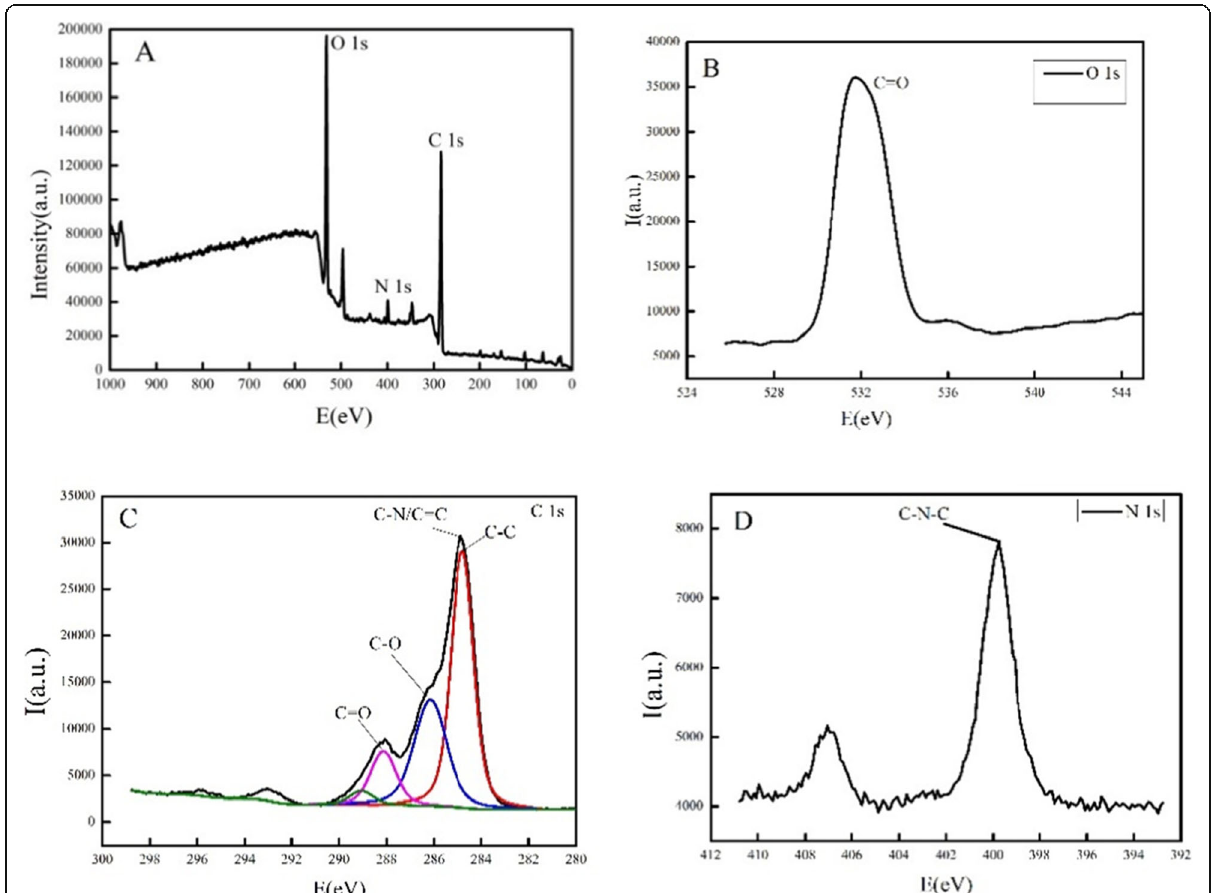
Fig. 4 The X-ray photoelectron spectroscopy of g-C 3 N 4 /N – C QDs